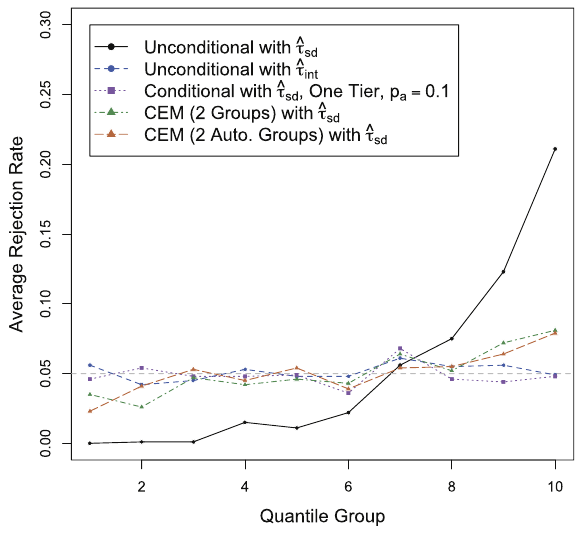
Figure 3: The rejection rate of the five randomization tests when Fisher’s Sharp Null Hypothesis is true (i.e., τ = 0) and β = 3. Rejection rates are shown within each quan- tile group of the Mahalanobis distance, such that each quantile group corresponds to 1,000